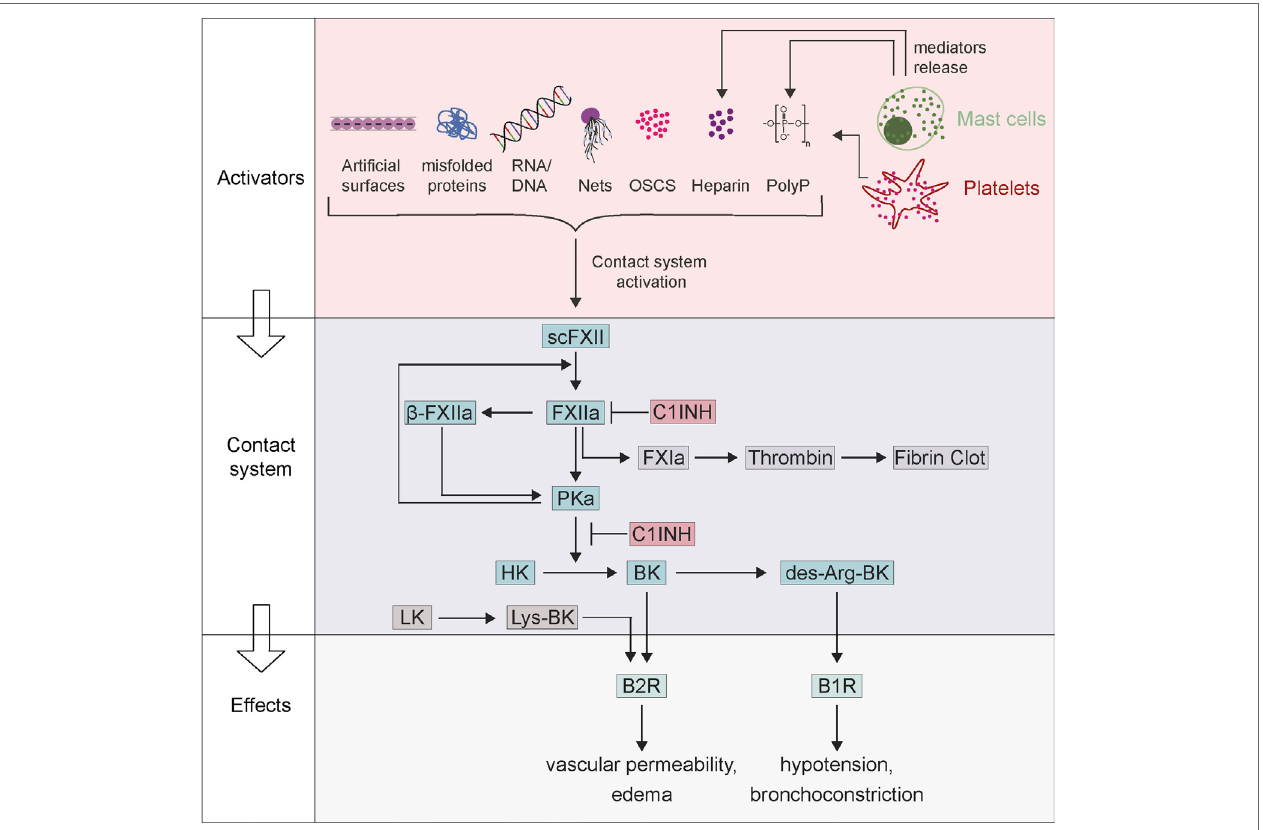
FiGURe 1 | Factor XII (FXII)-driven contact system in activation of anaphylaxis. Zymogen scFXII becomes activated to FXIIa either by endogenous activators [misfolded proteins, RNA/DNA, neutrophil extracellular traps (NETs), polyP, oversulfated chondroitin sulfate-contaminated heparin (OSCS-heparin) and heparin] or by artificial surfaces. Anaphylaxis can activate mast cells with the release of their mediators (polyP and heparin), which also leads to FXIIa. FXIIa proceeds to activate prekallikrein, which reciprocally cleaves both FXIIa into β -FXIIa and high-molecular-weight kininogen (HK) to bradykinin (BK). BK binds receptor B2 (B2R) and